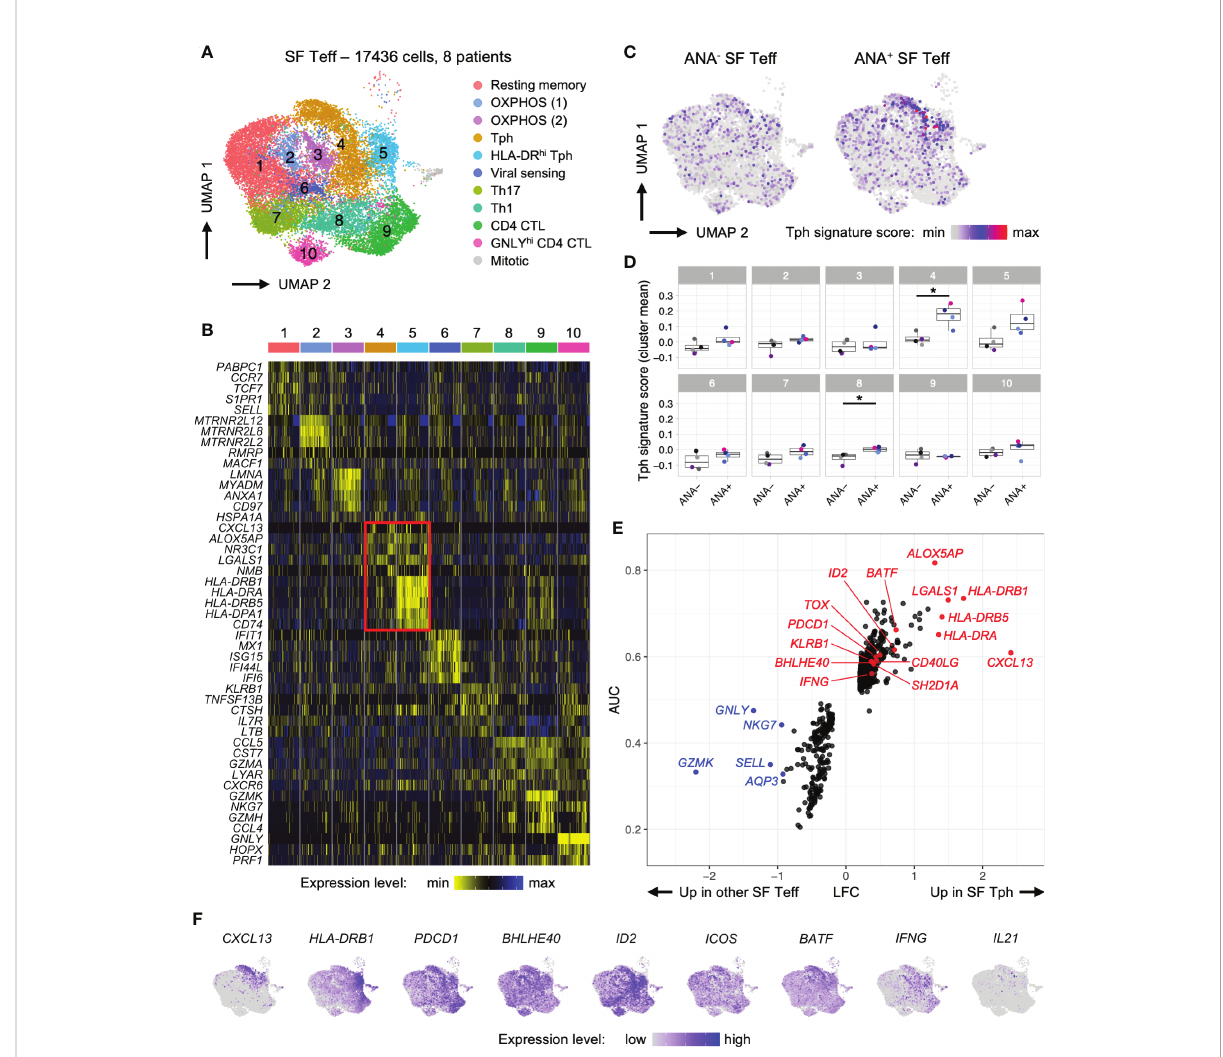
FIGURE 5 T peripheral helper cells in oligo JIA synovial fl uid adopt a distinctive transcriptomic signature characterized by robust expression of CXCL13. Combined data from two previously published datasets of oligo JIA SF Teff (CD4 + CD25 - ) cells studied with 10X Genomics (34, 45). (A) UMAP of SF Teffs from 8 oligo JIA patients, color-coded by cluster. (B) Heatmap of gene expression levels for the top 5 markers identi fi ed in each cluster using a Wilcoxon rank sum test, shown for 100 randomly selected cells from each cluster. (C) UMAP of SF Teffs split between ANA - (9667 cells) and ANA + (7769 cells) groups, color-coded with their Tph signature score. (D) Mean Tph signature score, averaged per patient and cluster. T-test comparisons of ANA - versus ANA + groups signi fi cant at a FDR of 0.05 are indicated with a star. (E) LFC versus AUC plot of differential expression analysis of SF Tph (Clusters 4 and 5) versus other SF Teffs (Clusters 1-3 and 6-10) run with Seurat v4 using the receiving operating characteristic (ROC) approach. (F) UMAP of SF Teffs showing expression levels of selected Tph genes in the top 95% percentile of the gene expression level distribution for each gene. Oligo JIA, oligoarticular juvenile idiopathic arthritis; SF, synovial fl uid; ANA, antinuclear antibody; Teff, T effector cell; Tph, T peripheral helper cell; OXPHOS, oxidative phosphorylation; CTL, cytotoxic lymphocyte; UMAP, uniform manifold approximation and projection; AUC, area under the curve; LFC, log2 fold change; FDR, false discovery